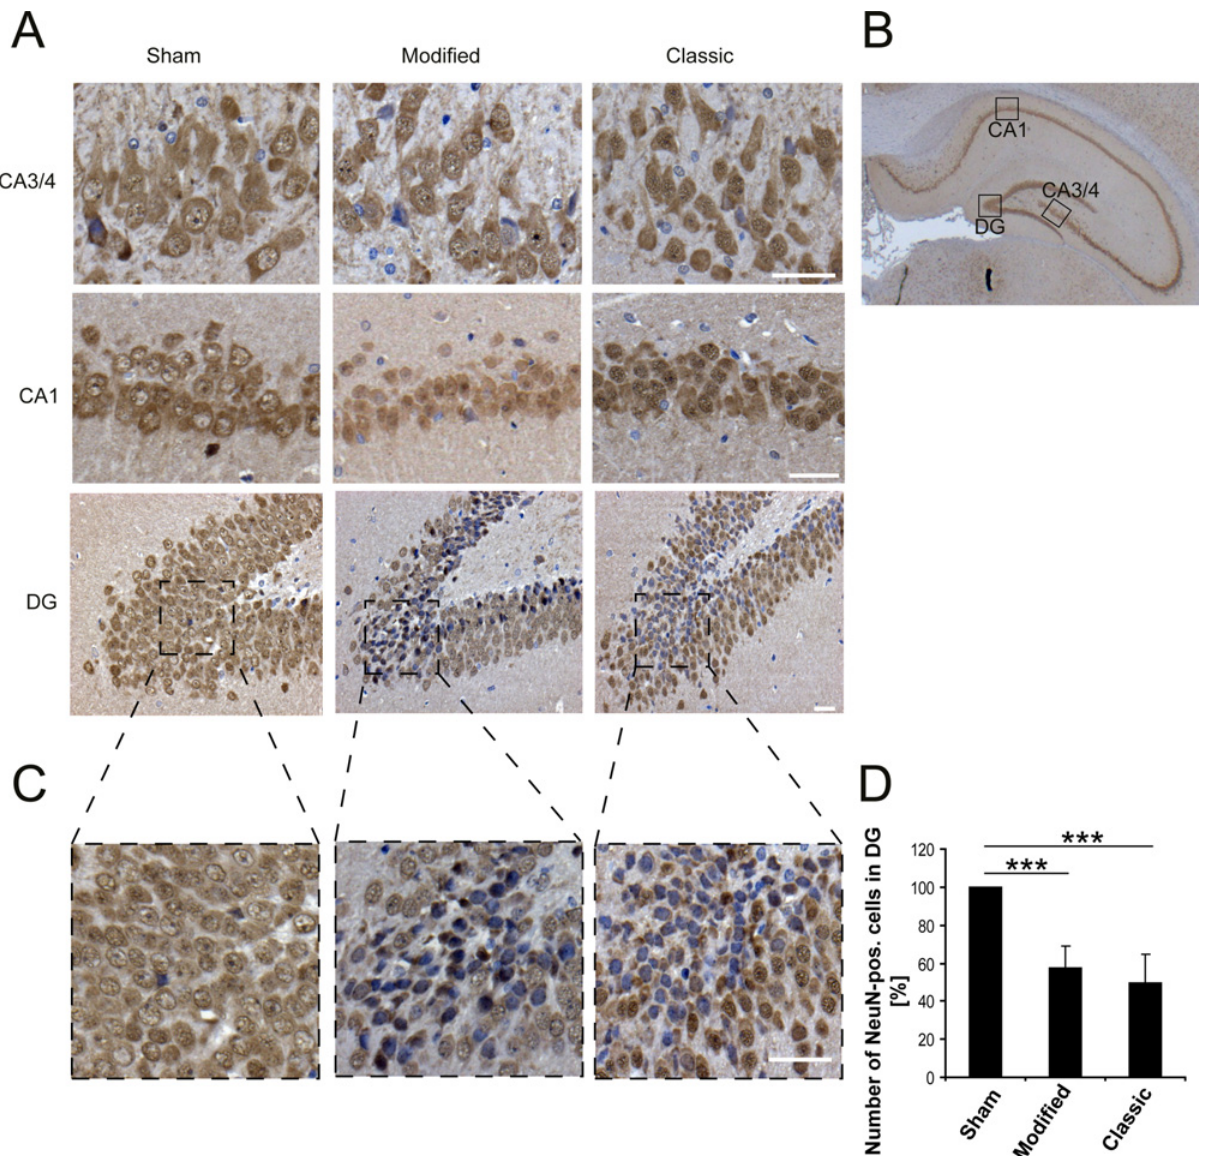
Fig 7. NeuN staining for 3 different hippocampal regions. Graph shows decrease of NeuN staining for 3 hippocampal regions (CA3/4, CA1 and dentate gyrus) 6 h after SAH independent from technique compared to sham surgery (A). Decrease of NeuN immunoreactivity predominantly is seen in dentate gyrus and significantly reduced 6 h after SAH (right lower corner: bar indicates 20 μ m). ( *** p <